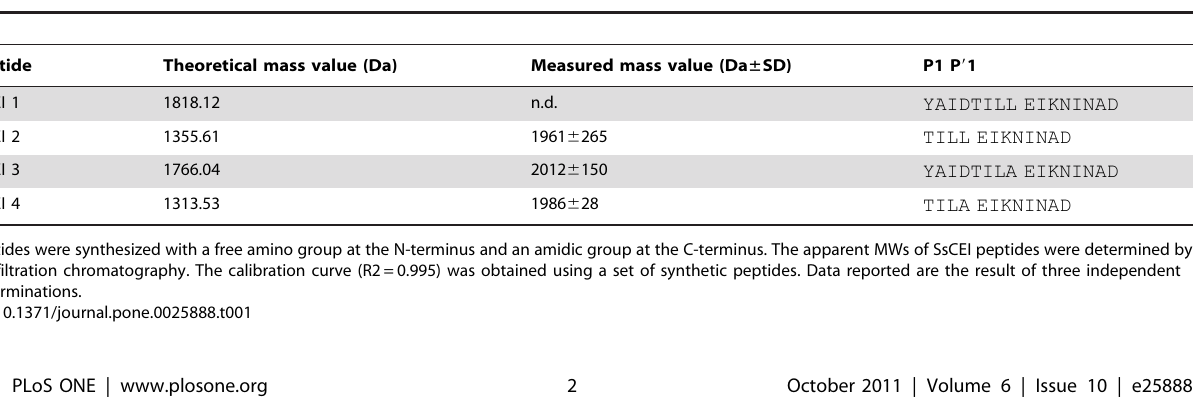
Table 1. Synthetic peptides used in this